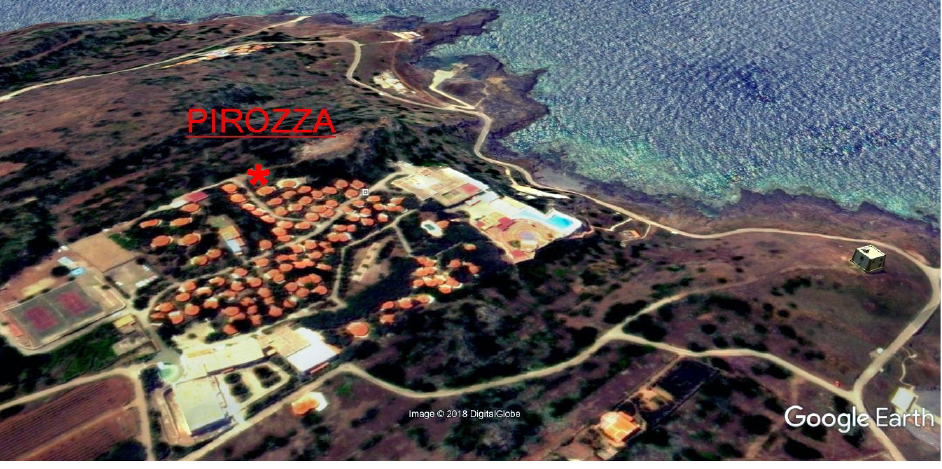
Figure 5 . Aerial view of the Pirozza hill and Spalmatore touristic village at Ustica Island, as seen from the north.The red aste- risk indicates the place where Neolithic ceramics and obsidian were found (modified from Google Earth).